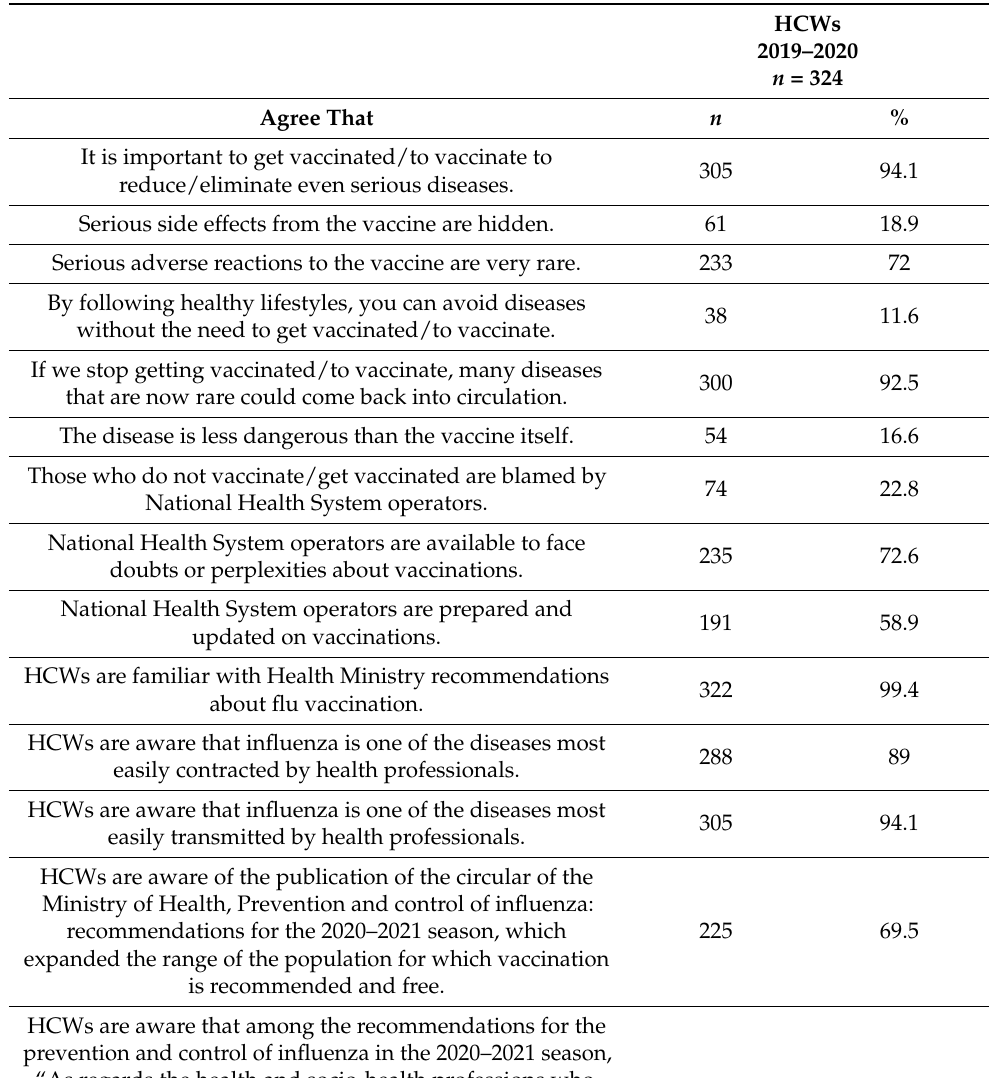
Table 1. Responses of HCWs concerning the knowledge and opinion about